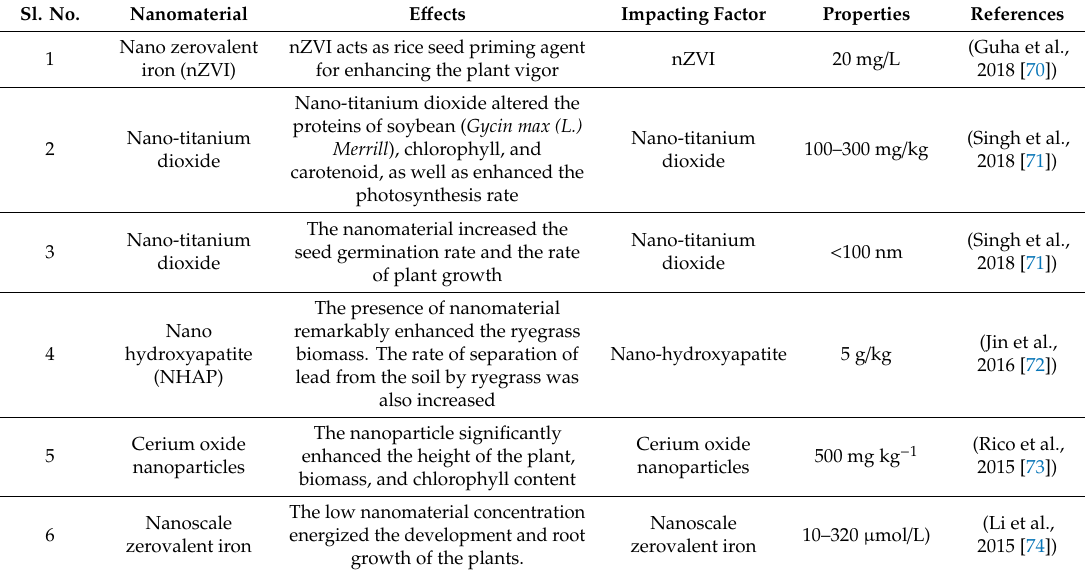
Table 1. Positive impacts of nanomaterials on